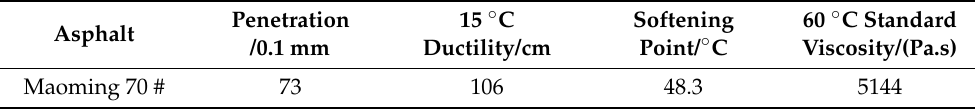
Table 5. Basic performance indexes of